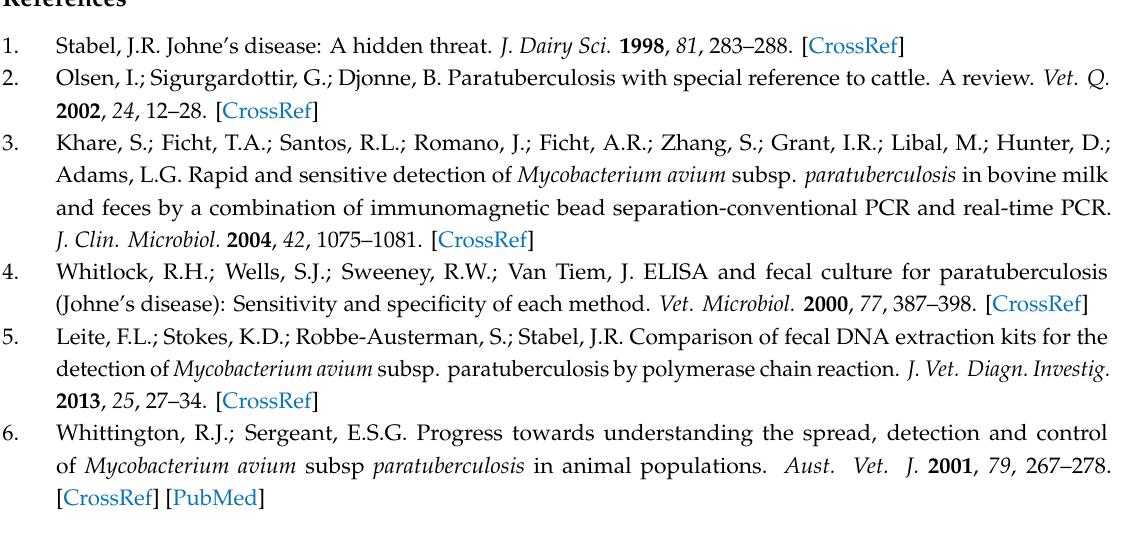
Figure S1: Distribution of DNA purity values of selected isolation kits for MAP DNA isolation from milk; Figure S2: Distribution of DNA purity values of selected isolation kits for MAP DNA isolation from faeces; Table S1: List of isolation kits used for isolation of MAP DNA from milk; Table S2: List of isolation kits used for isolation of MAP DNA from faeces; Table S3: List of isolation kits used for automatic magnetic separation of MAP DNA from milk and faeces; Table S4: Data derived from isolation e ffi ciency of MAP DNA from milk, unit:percentage [%]; Table S5: Data derived from isolation e ffi ciency of MAP DNA from faecal pellets, unit:percentage [%]; Table S6: Data derived from isolation e ffi ciency of MAP DNA from faecal samples, unit: percentage [%]; Table S7: E ffi ciency of MAP DNA isolation from milk; Table S8: Comparison of e ffi ciency of MAP DNA isolation from faeces; Table S9: Automatic magnetic separation of MAP DNA in milk; Table S10: Data derived from isolation e ffi ciency of MAP DNA automatic magnetic separation from milk, unit: percentage [%]; Table S11: Comparison of manual and automatic magnetic separation of MAP DNA in milk; Table S12: Comparison of isolation e ffi ciency derived data of MAP DNA manual and automatic magnetic separation from milk, unit:percentage [%]; Table S13: Concentration and purity of nucleic acids isolated from milk; Table S14: Concentration and purity of nucleic acid isolated from faecal pellets; Table S15: Concentration and purity of nucleic acid automatically isolated from